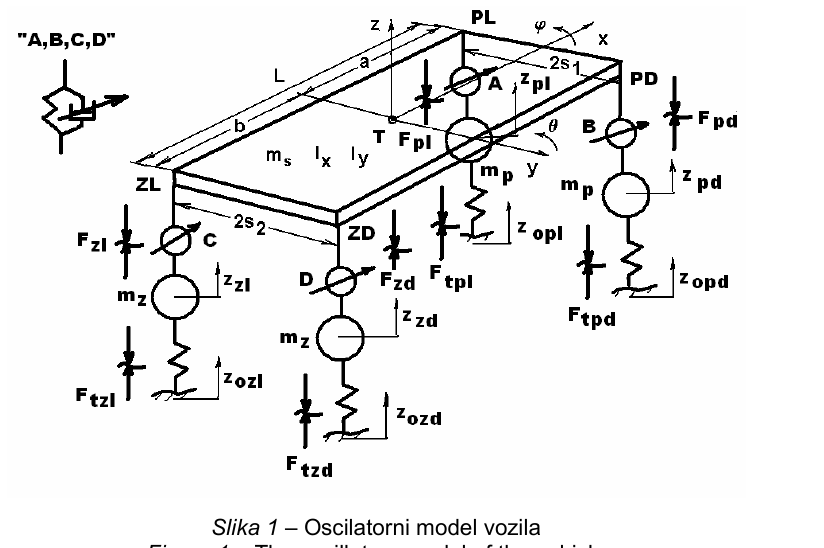
Figure 1 – The oscillatory model of the